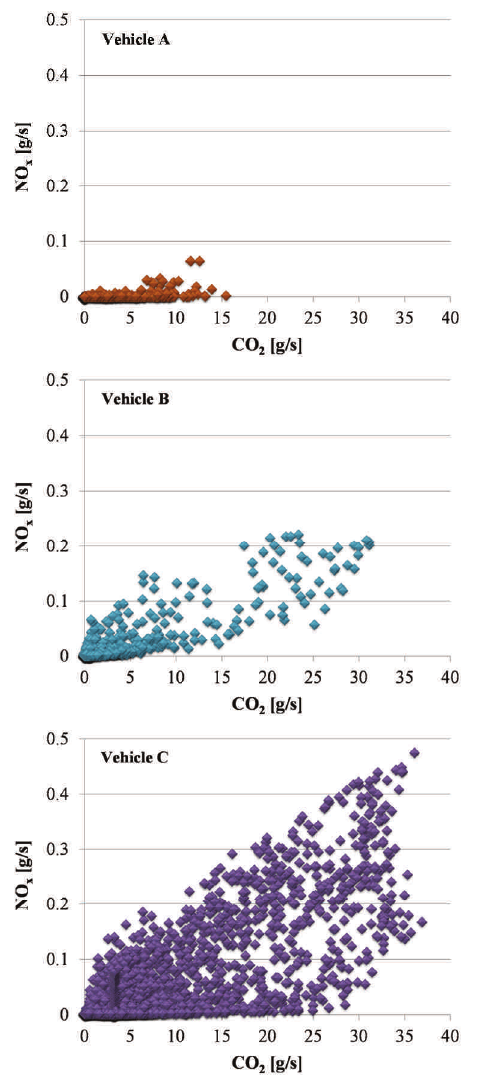
Fig. 7. Comparison of NO x and CO 2 emissions during road tests with respect to time compliance CO emission results in high values from the calculations. In addition, the resulting curves indicate incomplete combus- tion in the cylinders. The indicator reached a maximum value of 40. Whereas during acceleration, the indicator did not exceed the value of 4. Similar tendencies were observed for the vehicle C. The M_CO/CO ratio depends primarily 2 on braking. Despite the hybrid system, vehicle movement had a significant impact on the characteristics. It should also be noted that the maximum toxicity indicator values were even five times greater than in the vehicle B